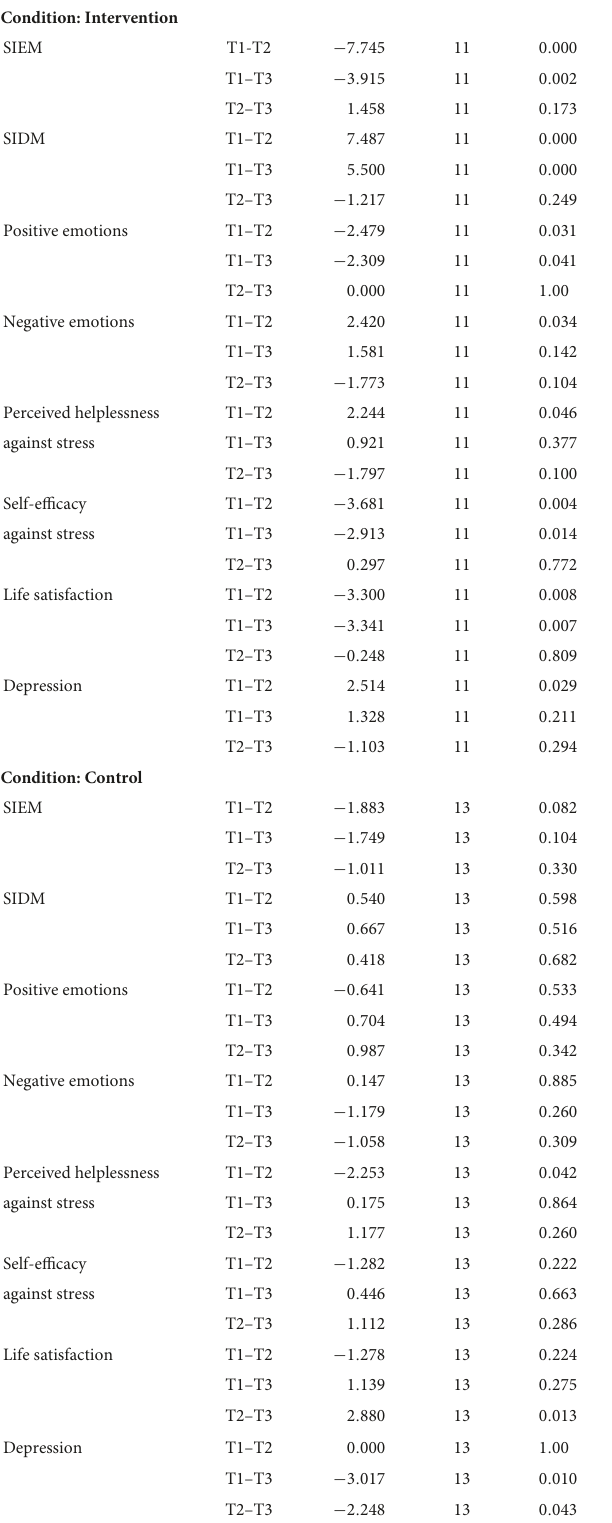
TABLE 3 Paired-samples t -test coefficients for the mean comparison of pairs between the three time-points as a function of condition. Pairs t df p